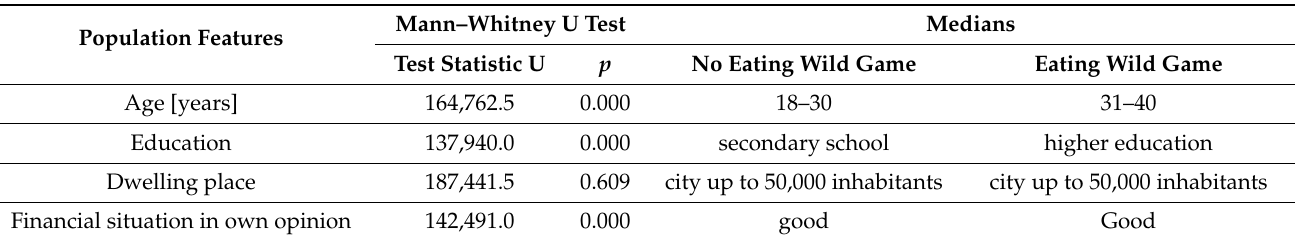
Table 2. Values of test statistics and significance p in the Mann–Whitney U test and median values in the group of people consuming and not consuming